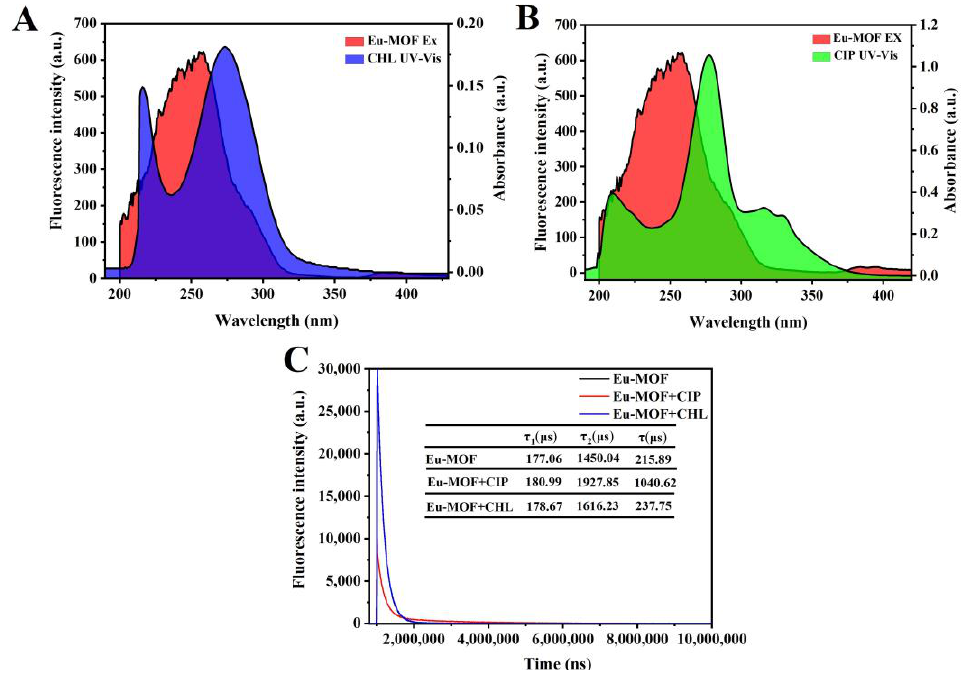
Figure 2. Fluorescence excitation spectra of Eu − MOF overlaid with the UV − vis absorption spectra of ciprofloxacin ( A ) and chloramphenicol ( B ); ( C ) fluorescence lifetime spectra of Eu − MOF before and after the addition of ciprofloxacin and chloramphenicol.